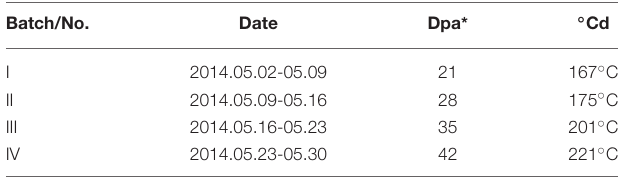
TABLE 1 | Details of grain samples harvested during the post-anthesis period based on thermal time corresponding to cumulative average daily